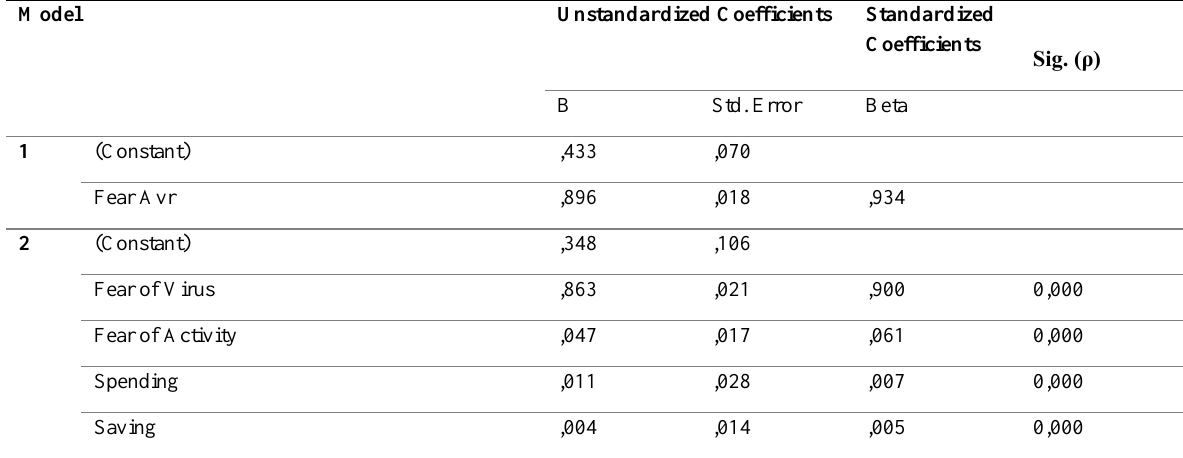
Table 6: Multiple Linear Regression Test Results Coefficients